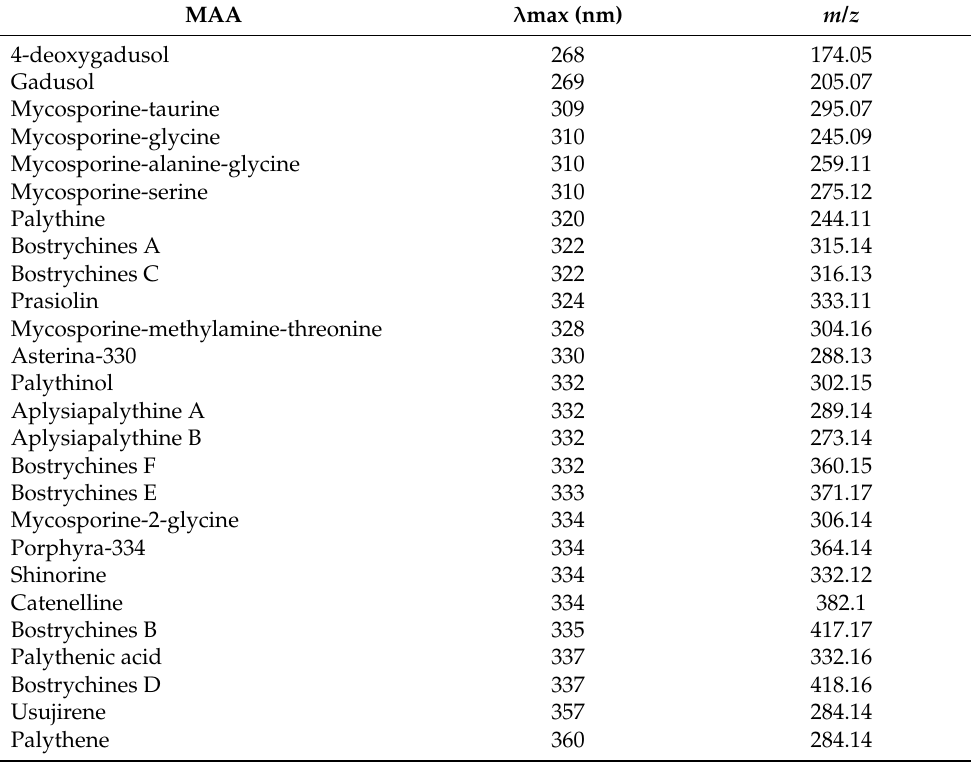
Table 1. Mycosporine-like Amino Acids (MAA) from red